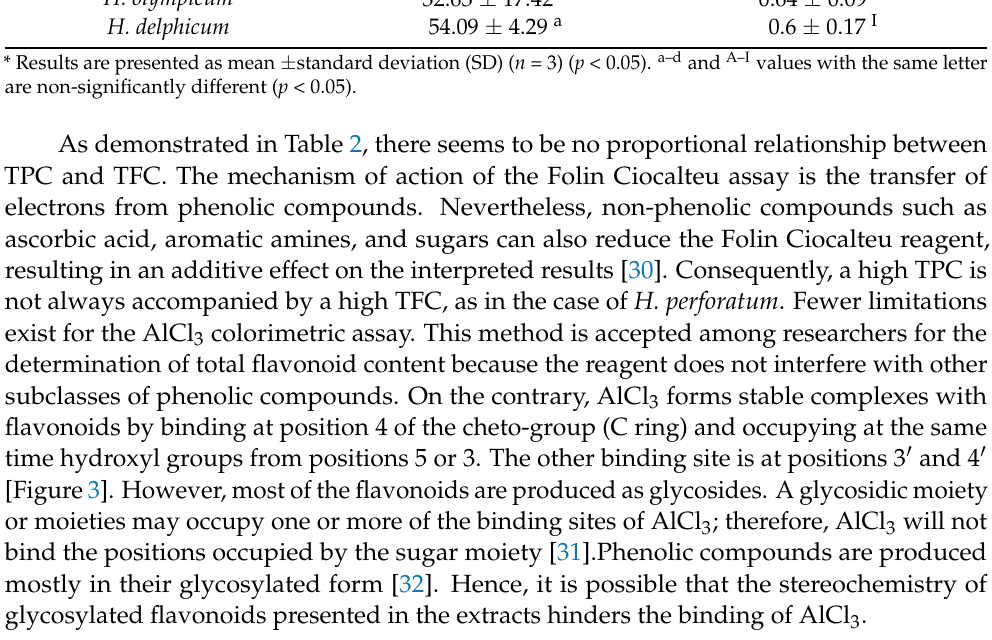
Table 2. Total phenolic and total flavonoid content of the Hypericum species examined. Species TPC ± SD TFC ± SD mg GAE/g dry plant material mg RE/g dry plant material H. perfoliatum 59.31 ± 16.47 a, * 0.21 ± 0.14 A H. rumeliacum subsp. apollinis 54.87 ± 2.73 a 1.18 ± 0.22 B H. vesiculosum 26.92 ± 10.32 b H. cycladicum 54.59 ± 8.55